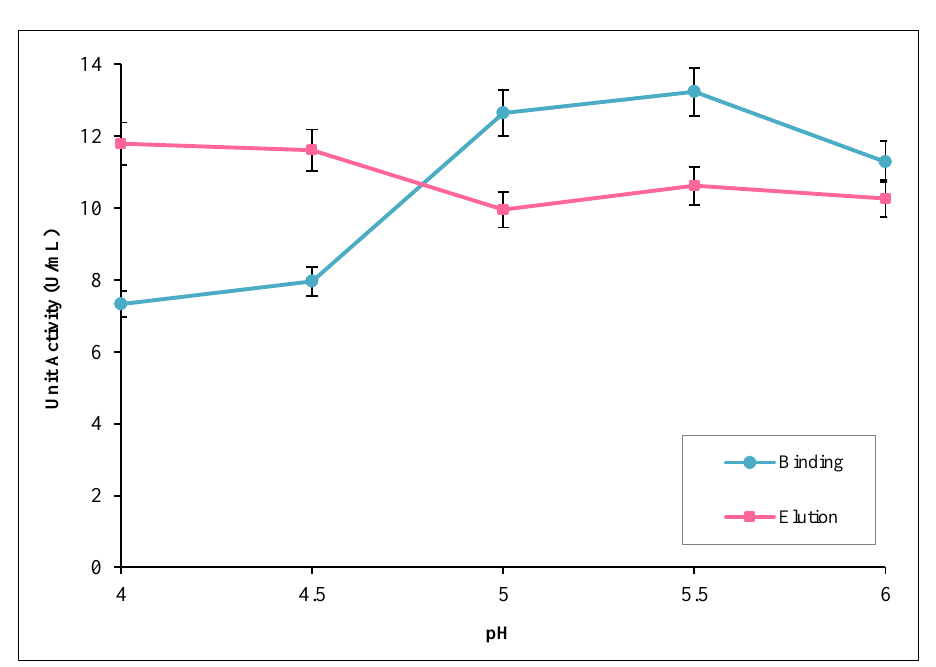
Figure 2. Initial buffer pH for enzyme immobilization (mean ± SD; n = 2; p <